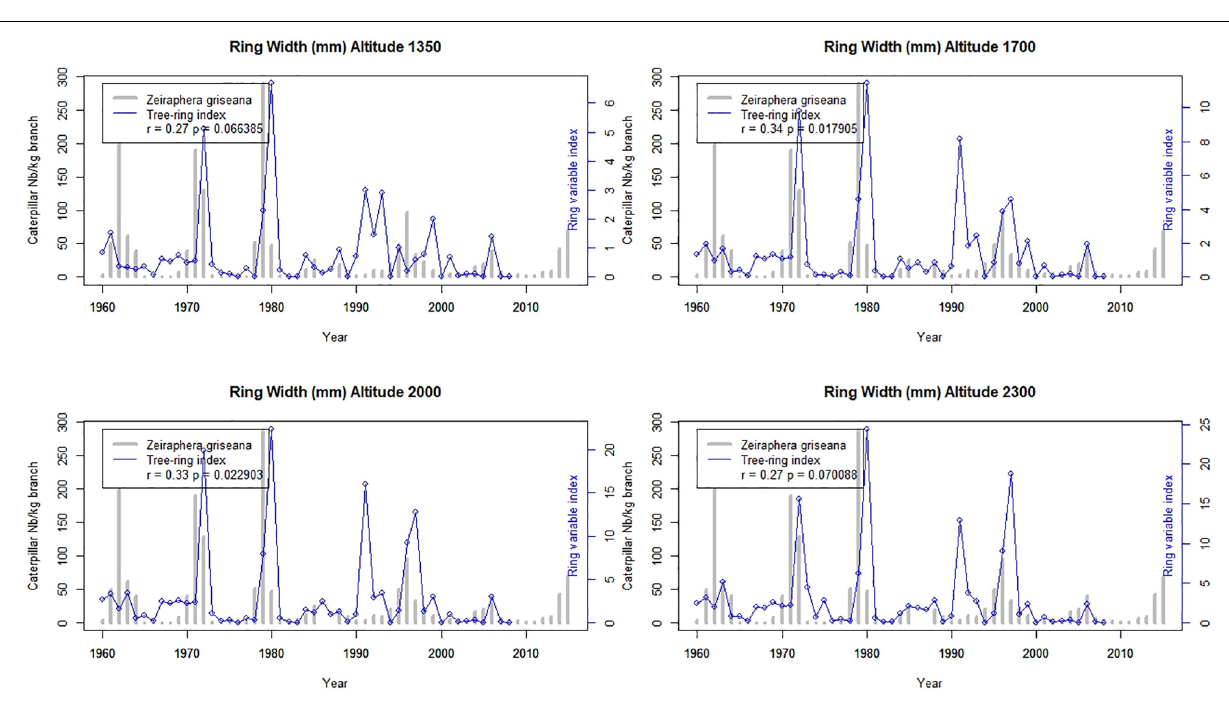
FIGURE 5 | Ring width outbreak index at four elevations along the elevational gradient from 1960 to 2007 and the Les Combes outbreaks from 1960 to 2015. Reconstructed LBM outbreaks (blue lines) and direct observations at Les Combes (gray